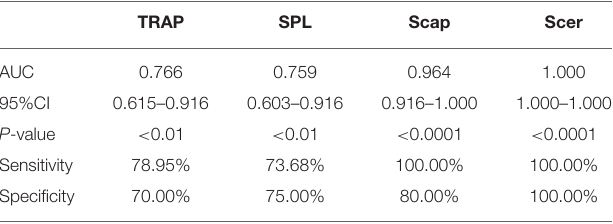
TABLE 2 | The diagnostic ability of superficial cervical extensor muscle stiffness for